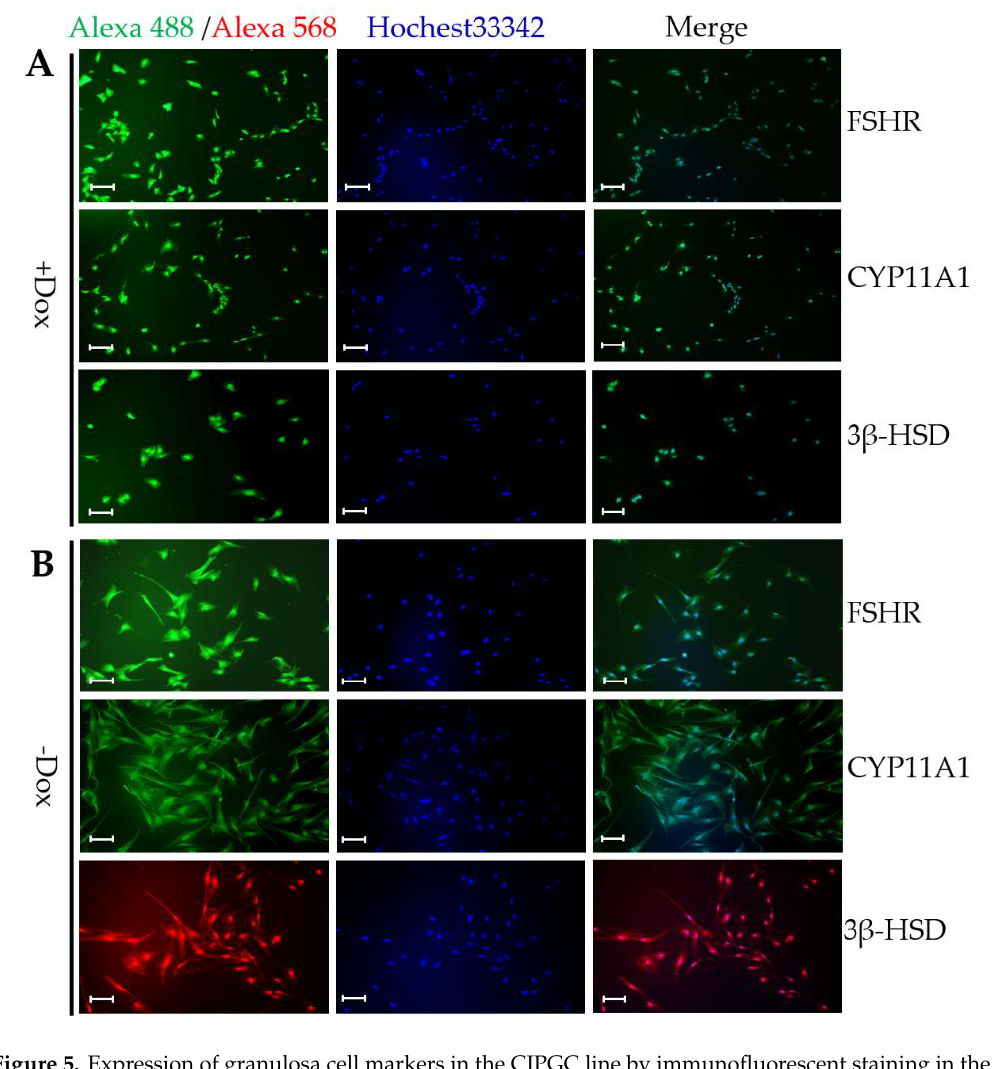
Figure 5. Expression of granulosa cell markers in the CIPGC line by immunofluorescent staining in the presence and absence of Dox. Immunofluorecent staining of FSHR, CYP11A1, and 3β -HSD in CIPGCs with ( A ) and without ( B ) Dox induction. CYP11A1, cytochrome progesterone 50 family 11 subfamily A member 1; 3β - HSD, 3β -hydroxysteroid dehydrogenase; FSHR, follicular stimulating hormone receptor. The experiment was repeated twice. Bar at 50 µm.